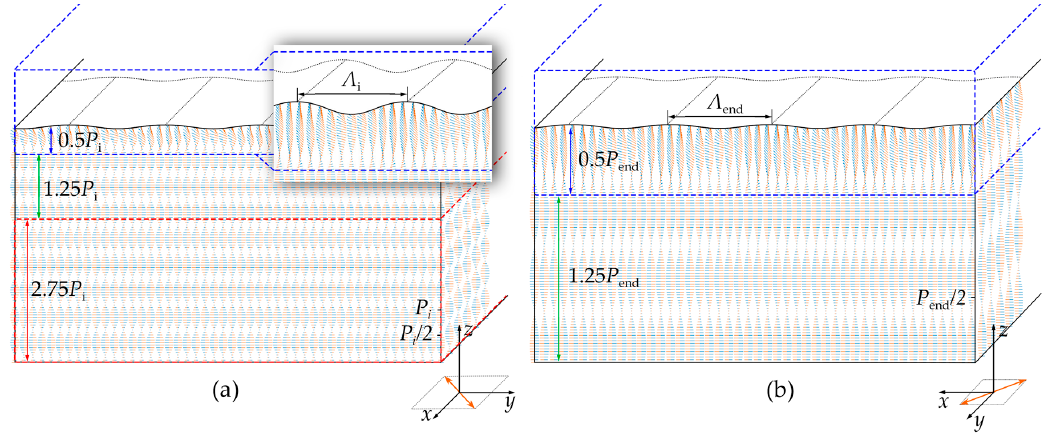
Figure 4. Simulated director configurations of the CLC grating (1 wt % ChAD-3c-S) at the ( a ) initial state and ( b ) end state. The inset in ( a ) shows a zoomed-in image. The anchoring directions are represented by orange arrows.